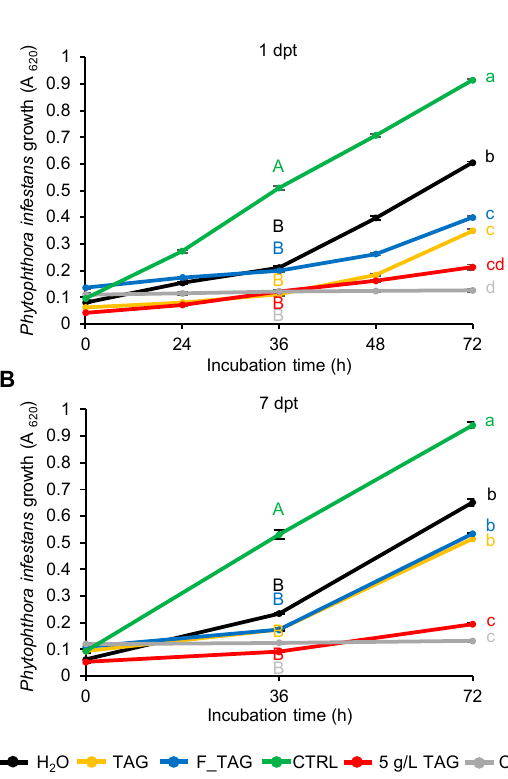
Figure 2. Phytophthora infestans growth in the presence of leaf washing suspensions. Phytophthora infestans sporangia were incubated in the presence of leaf washing suspensions collected at one ( A ) and seven ( B ) days post-treatment (dpt) from plants treated with water (H 2 O; black), 5 g/L pure tagatose (TAG; yellow) or a formulated product that contained 5 g/L tagatose (F_TAG; blue). Spo- rangia were incubated in water (CTRL; green), tagatose (5 g/L; red), and copper hydroxide (10 g/L; grey) as controls. P. infestans growth was assessed by measuring the absorbance at 620 nm (A 620 ) at 0, 36, and 72 h of incubation. The two-way analysis of variance (two-way ANOVA) showed no significant differences between the two experimental repetitions ( p > 0.05, three replicates per ex- periment), and data from the two experiments were pooled. Mean and standard error values of six replicates (wells) from the two experiments are presented for each treatment. Different uppercase and lowercase letters indicate significant differences among treatments at 36 and 72 h of incubation, according to Tukey’s test ( p ≤ 0.05). No differences were found among treatments at 0 h of incuba- tion, according to Tukey’s test ( p > 0.05).